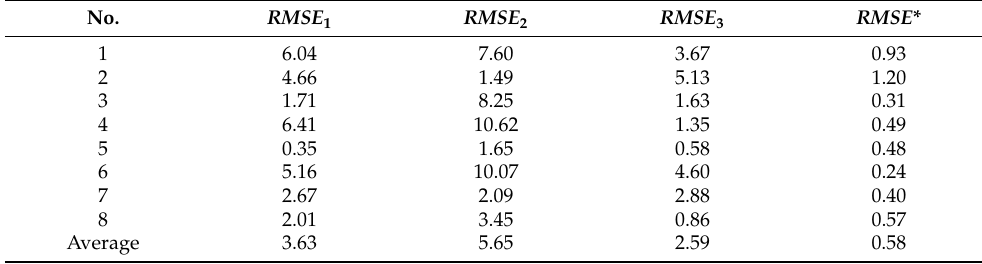
Table 4. The RMSE for three input